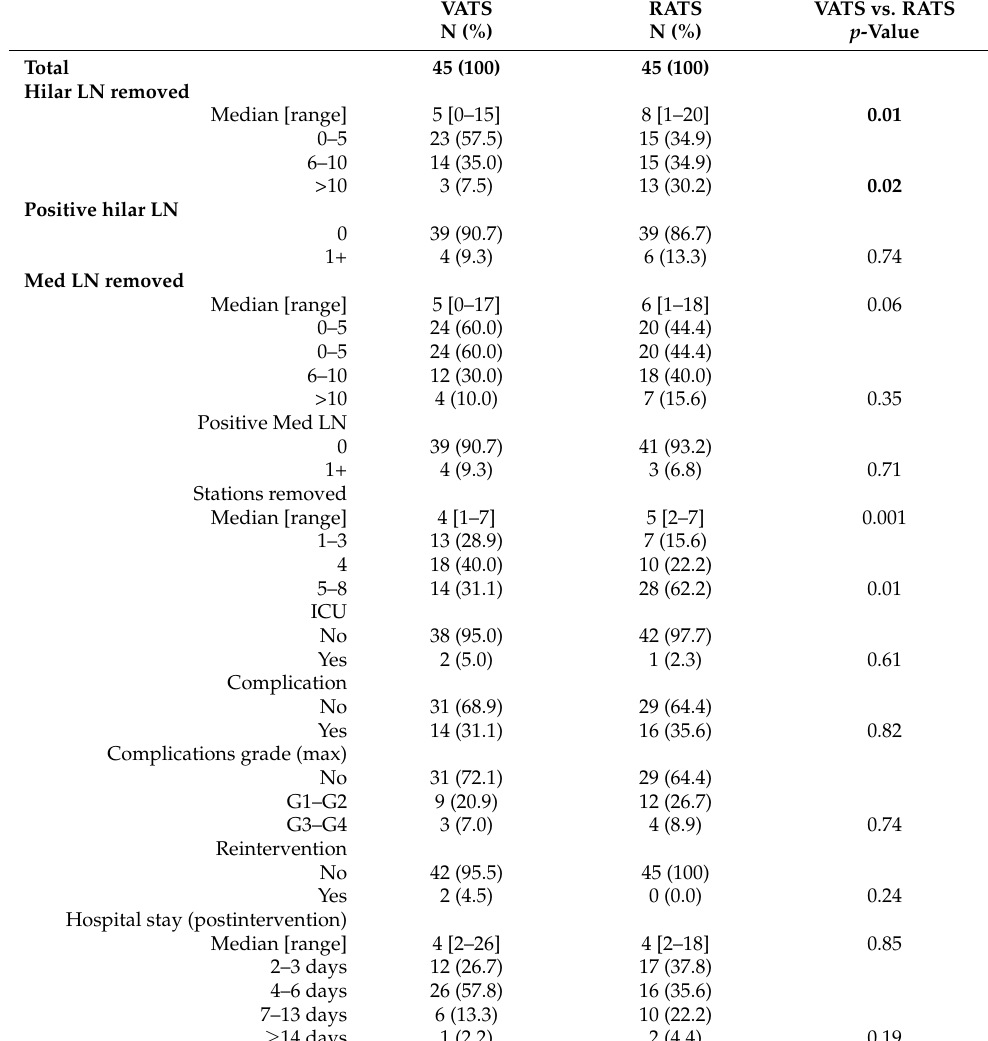
Table 5. Perioperative outcomes and pathological results in the matched RATS and VATS intervention groups.